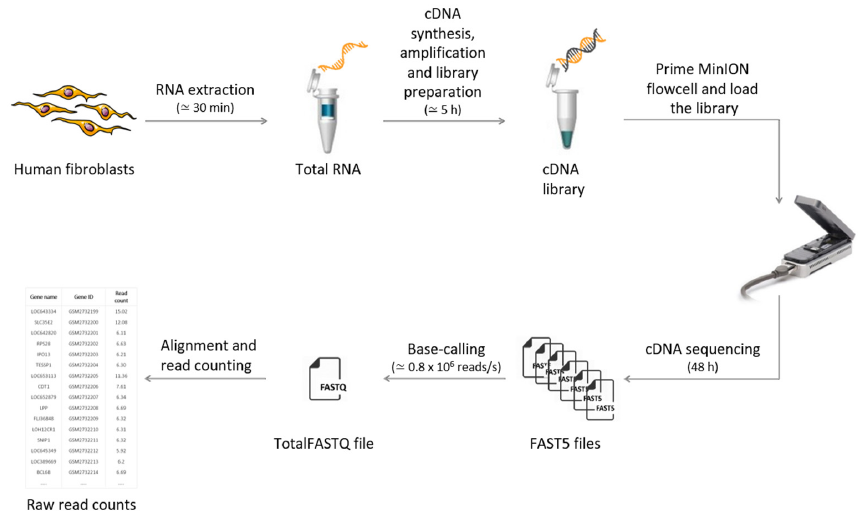
Figure 1. Study workflow. RNA was extracted from human cardiac fibroblast cells. Then, cDNA library preparation (including size, quantity, and quality analysis), base calling, read mapping, and counting were performed.